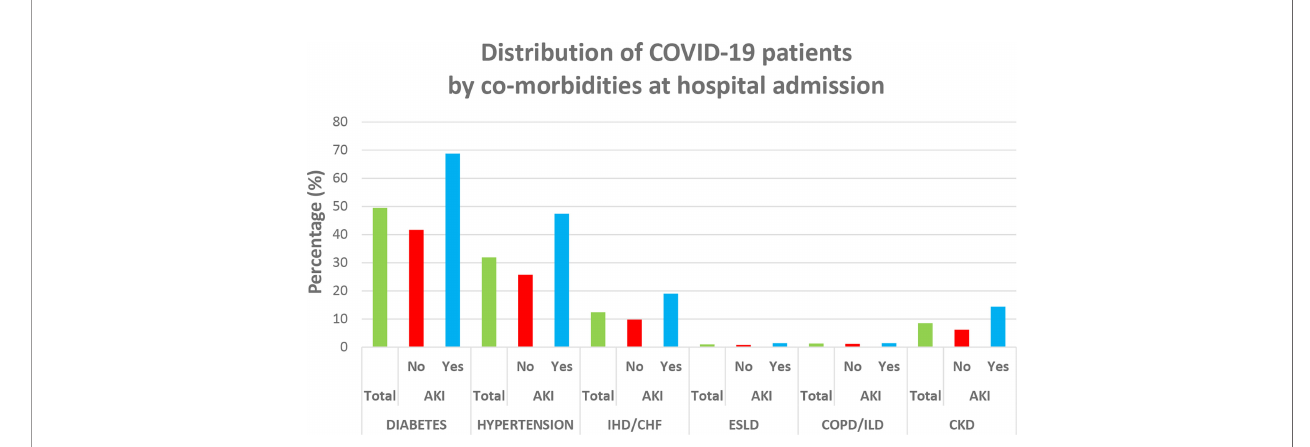
FIGURE 4 | Distribution of comorbidities among COVID-19 patients at hospital admission. IHD, ischemic heart disease; CHF, chronic heart failure; CKD, chronic kidney disease; COPD, chronic obstructive pulmonary disease; ILD, interstitial lung disease; ESLD, end-stage liver